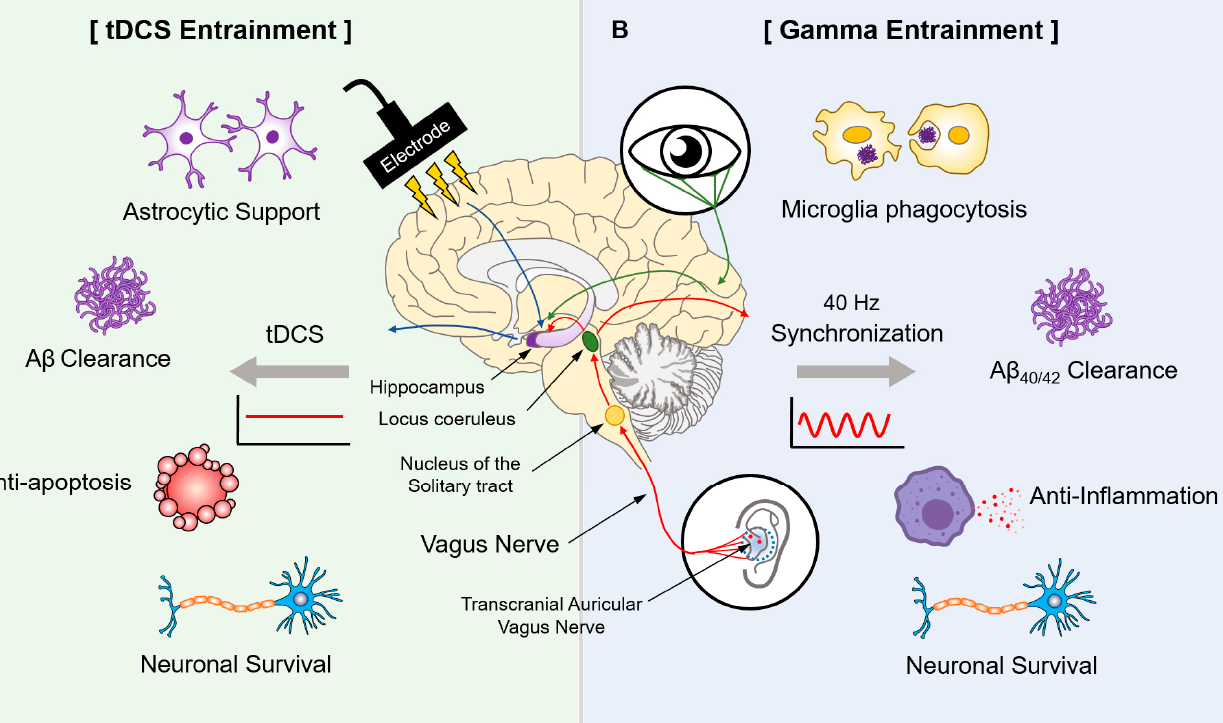
Figure 2. Therapeutic effects of electrical waves such as tDCS and gamma entrainment in AD. ( A ) Stimulation using tDCS results in the astrocytic support, A β clearance, anti-apoptosis, and a neuronal survival effect in the brain after exposure. ( B ) The transcranial auricular vagus nerve and audiovisual sensory nerve are stimulated for 40-Hz gamma oscillation, which activates microglia phagocytosis, A β clearance, anti-inflammation, and increased neuronal